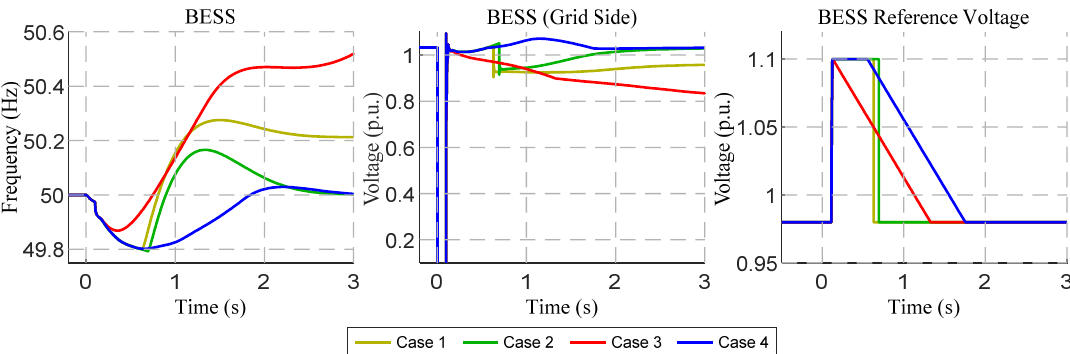
Figure 28. BESS power converter synthetic frequency, grid side terminal voltage and reference and voltage reference for voltage control loop.